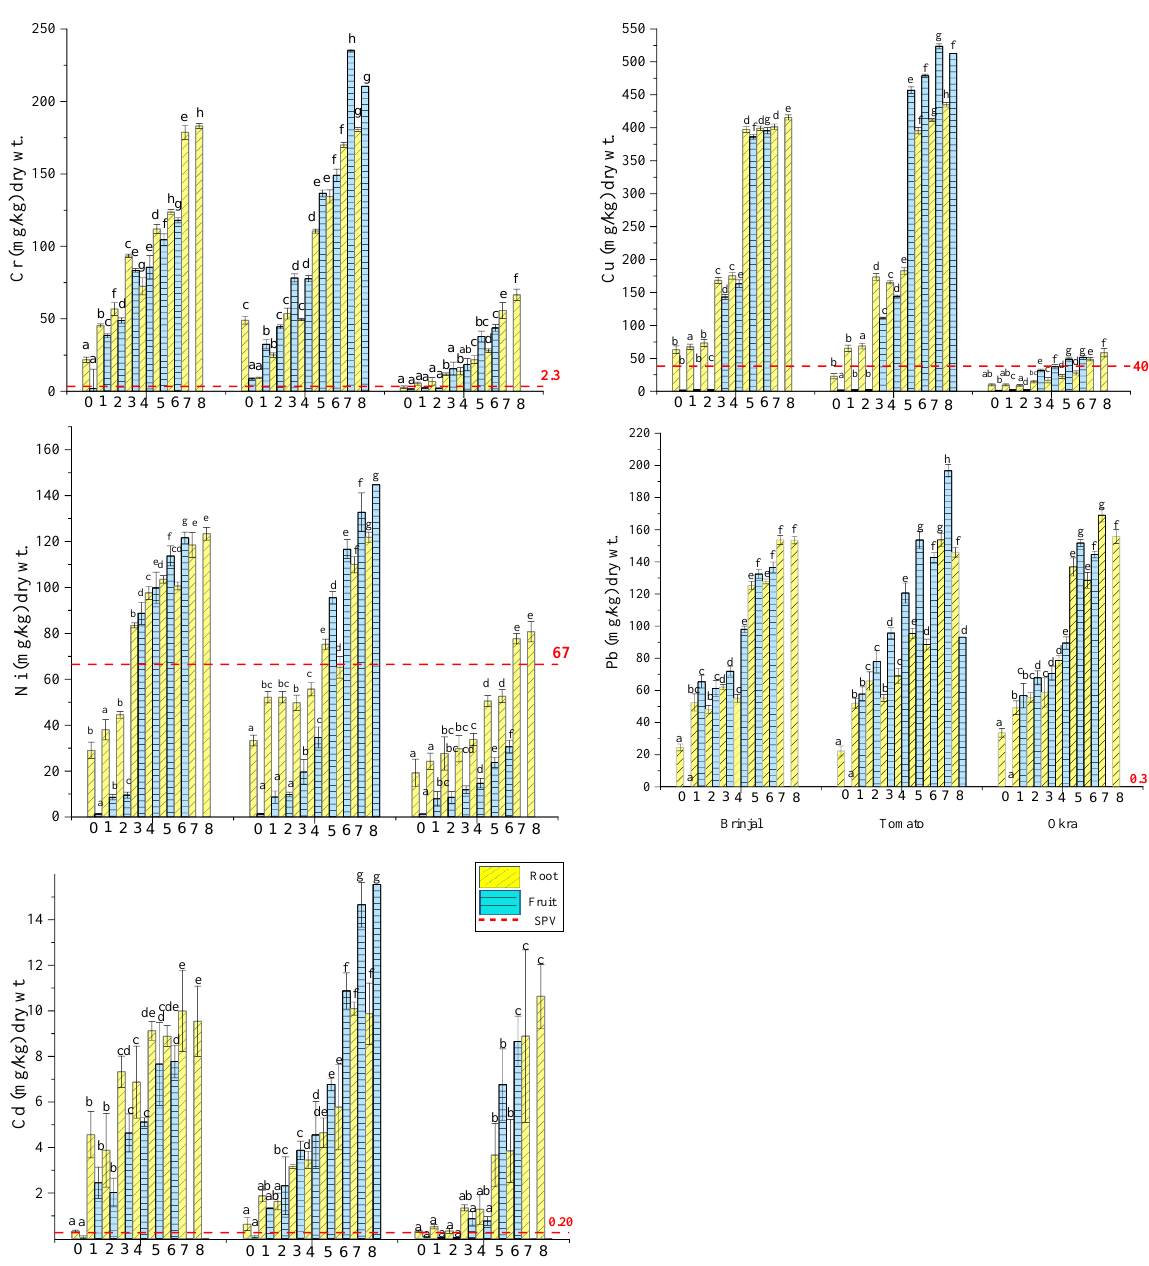
Figure 3. Metal concentration (mg/kg dry weight) in roots and fruits of crops under different MSWC concentrations, noted as 0(T0), 1(T1-B), 2(T1-O), 3(T2-B), 4(T2-O), 5(T3-B), 6(T3-O), 7(T4-B), and 8(T4-O). Means with different letters are significantly different at p < 0.05. Each point represents the mean of three replicates, and the error bars represent the standard deviation.